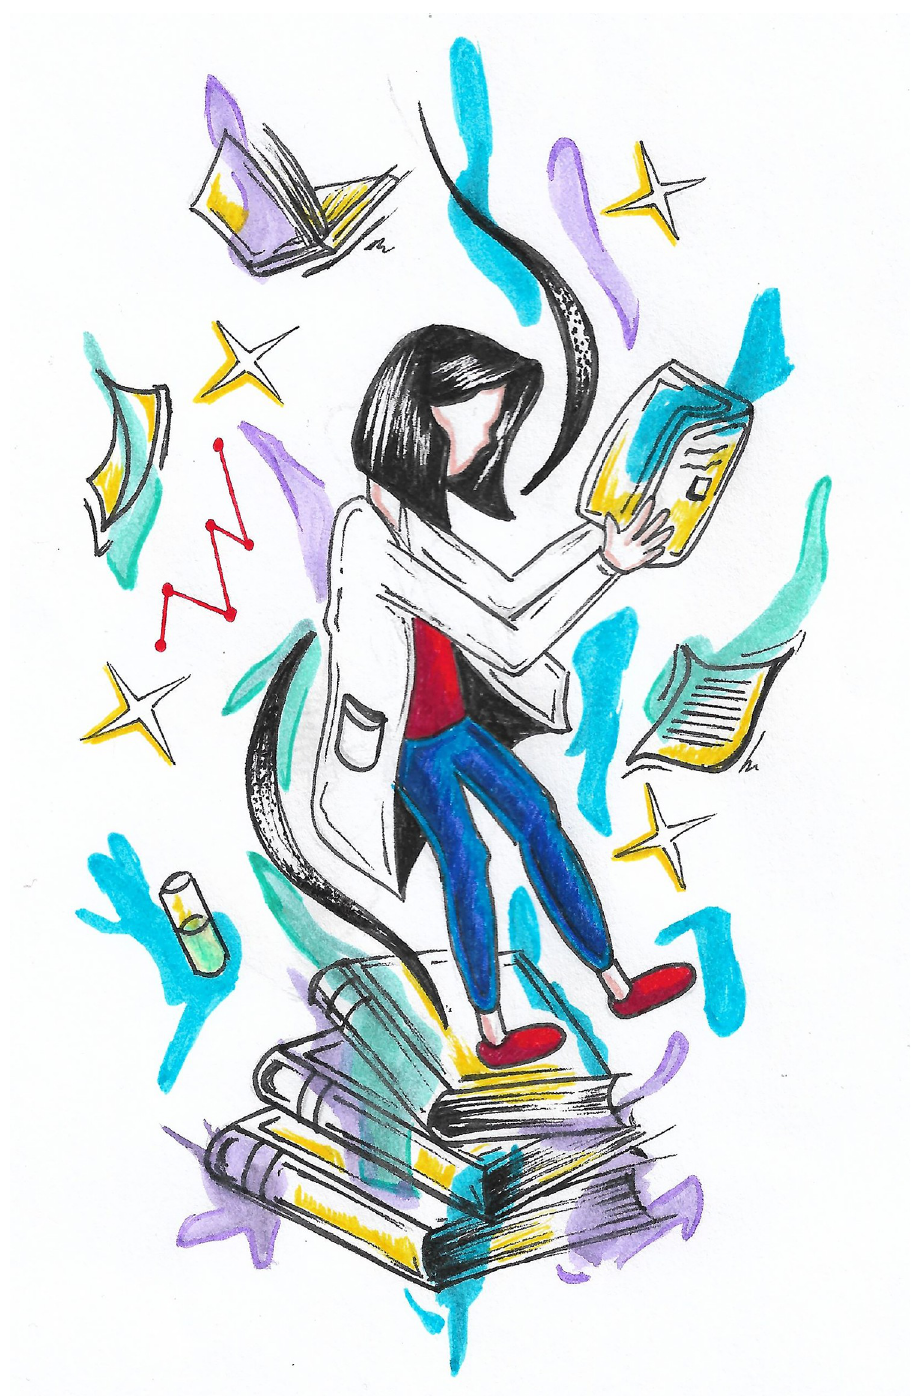
Fig 6. Research and publish. Women scientists require more actions that promote the publishing of their research (Illustrated by Jose Faustino Villa).